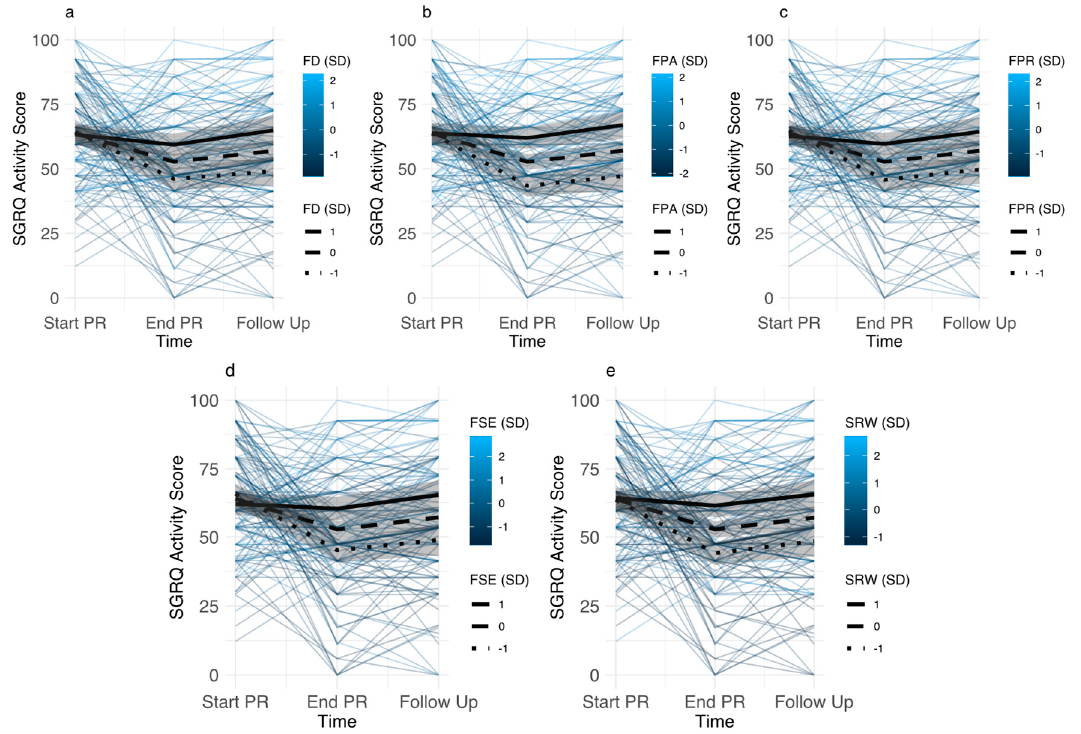
Figure 3. Individual trajectories of St. Georges respiratory questionnaire (SGRQ) activity scores for participants with different levels of disease-specific fears (color indicates level of disease-specific fear). Estimated trajectories for participants with disease-specific fear scores 1SD above mean, mean, and 1SD below mean (95% CI) are superimposed. ( Panel a ): Fear of Dyspnea (FD), ( Panel b ): Fear of Physical Activity (FPA), ( Panel c ): Fear of Progression (FPR), ( Panel d ): Fear of Social Exclusion (FSE), ( Panel e ): Sleep-Related Worries